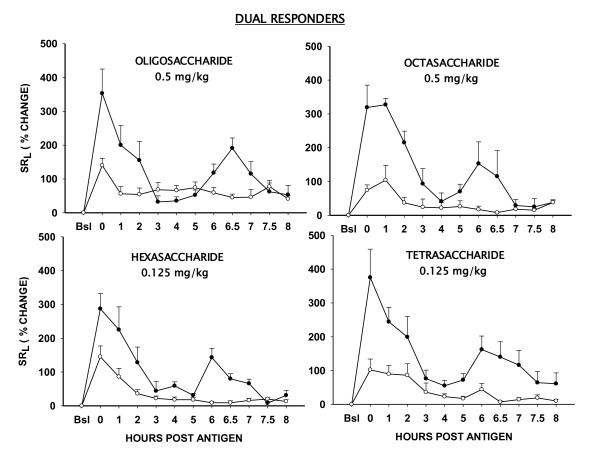
Effect of inhaled heparin oligosaccharides on antigen-induced early and late airway responses (EAR and LAR) in "Dual Responder" sheep. Data are shown as % change in specific lung resistance (SRL) ± SE without (solid circles) and after (open circles) pretreatment with oligosaccharide mixture (n = 6; 0.5 mg/kg), and various fractions including octasaccharide (n = 3; 0.5 mg/kg), hexasaccharide(n = 5; 0.125 mg/kg), and tetrasaccharide (n = 5; 0.125 mg/kg). Bsl = Baseline.